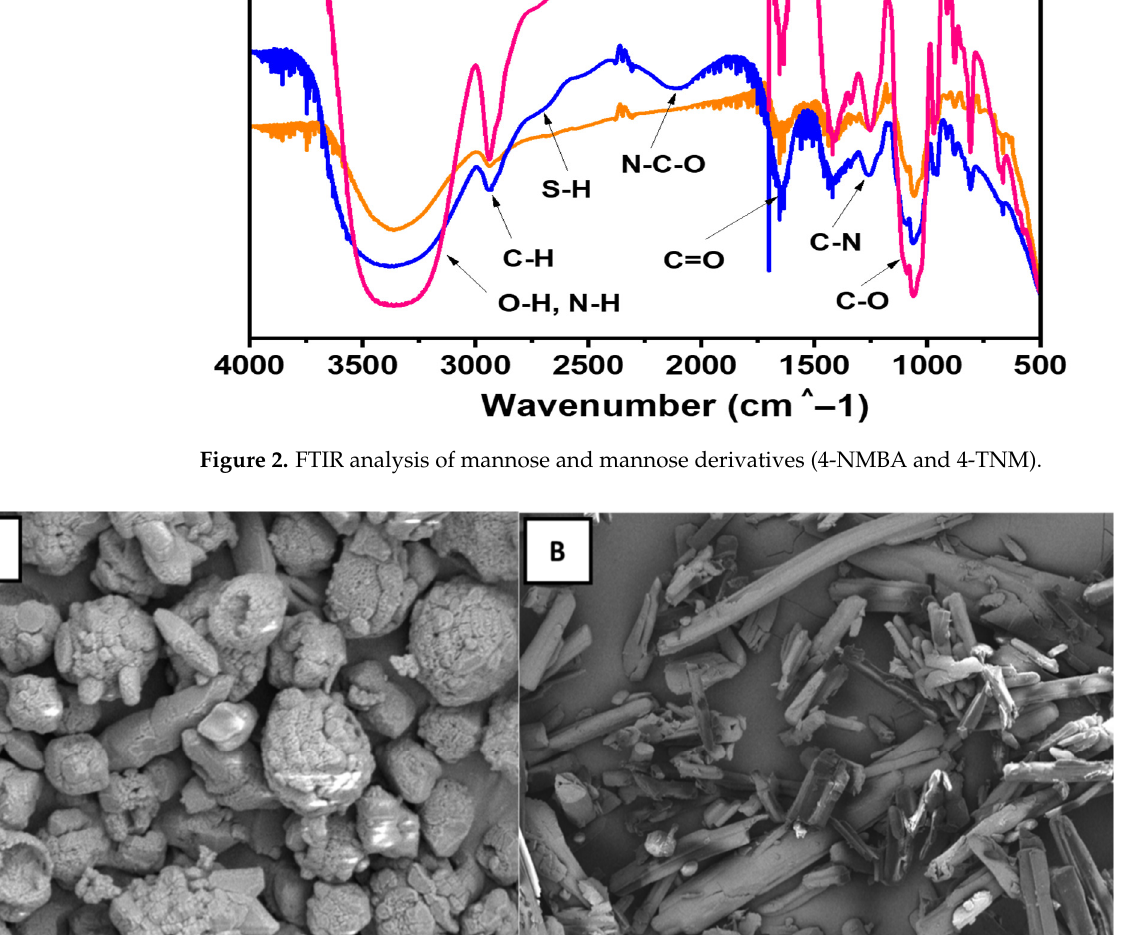
Figure 2. FTIR analysis of mannose and mannose derivatives (4-NMBA and 4-TNM).